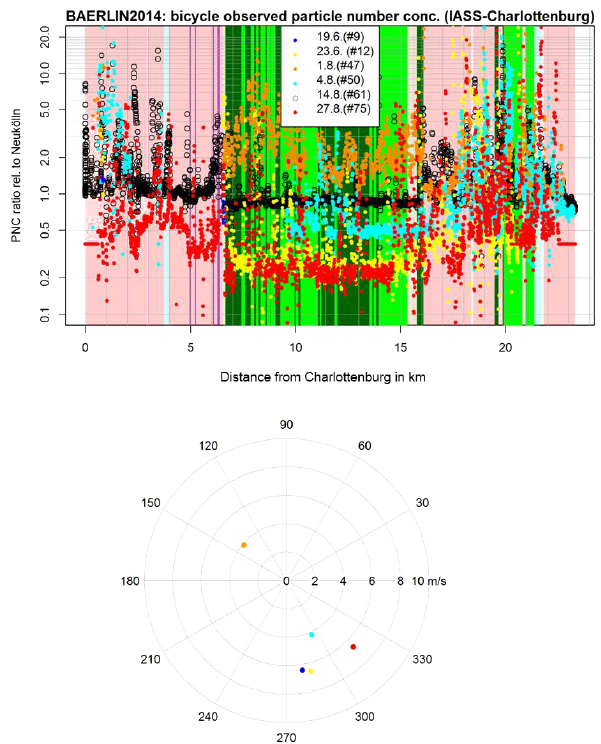
Figure 11. Top: measurements by bicycle, following the same route, Charlottenburg (Berlin) to IASS (Potsdam), on different days and during different times. The dots plotted are particle number concentration ratios relative to the stationary site in Neukölln with a time resolution of 10s. Green shaded areas are vegetated areas; pink shaded areas are anthropogenically dominated areas. Bottom: wind rose and speed at Tempelhof (DWD) measured for the times of the individual tracks. The color coding is identical with that in the upper graph. Note that the corresponding wind data for track 61 are not